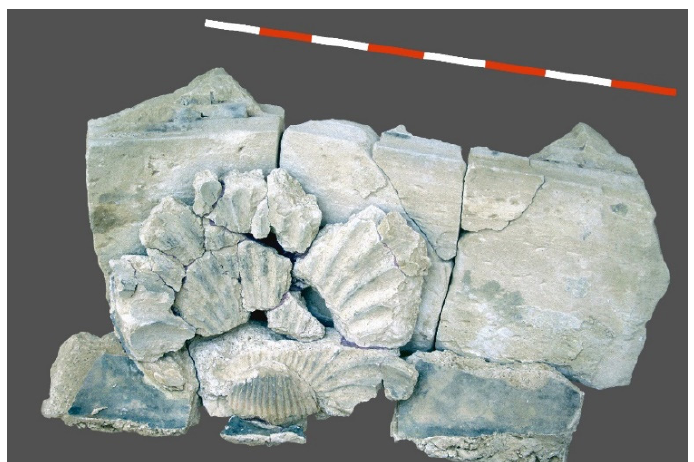
Figure 19. Remains of a shell painted blue decorating the intrados of the pediment of the aedicula from the oikos of house H10 (photo Rafa ł Czerner).